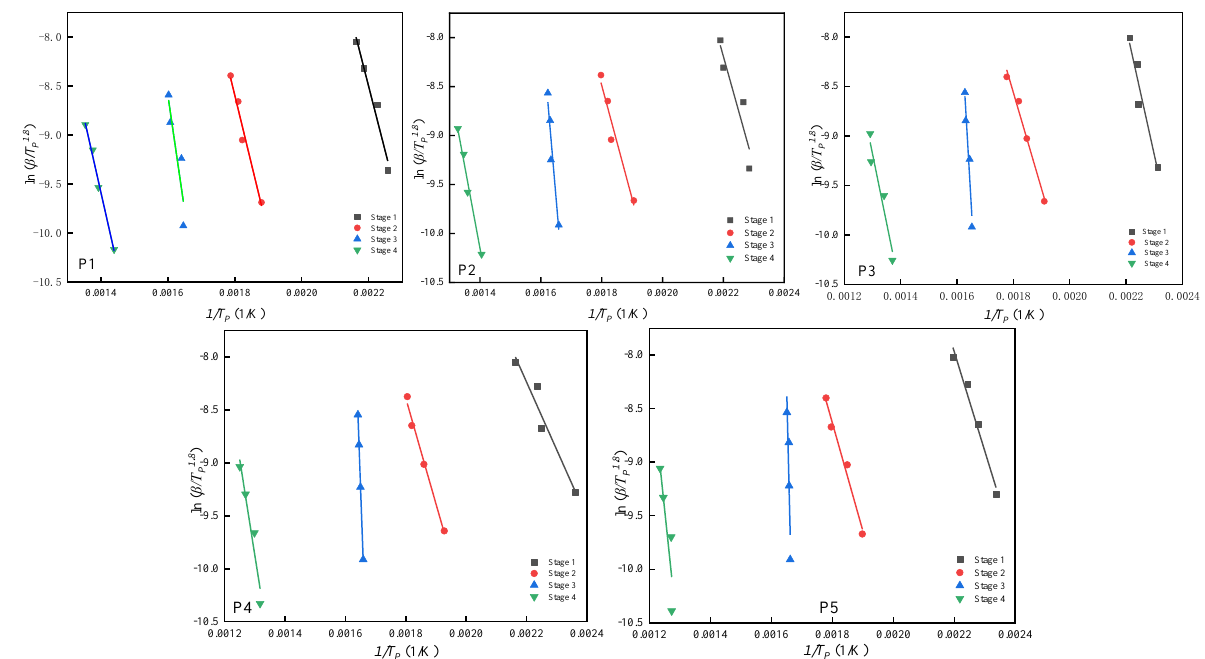
Figure 12. Activation energy curve of Samples P1 – P5 at each stage of pyrolysis calculated via Starink’s method.